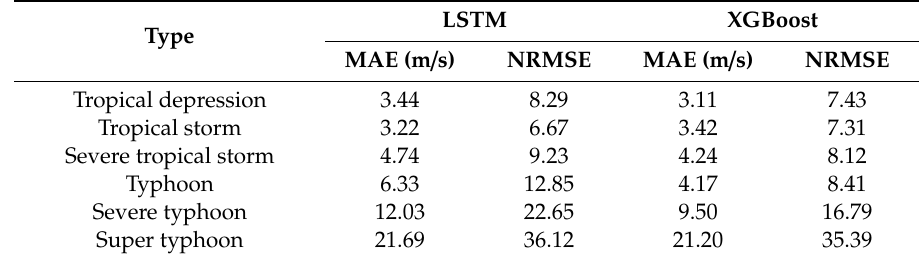
Table 11. LSTM and XGBoost model errors for di ff erent tropical cyclone intensity levels at an 18 h lead time. LSTM XGBoost Type MAE (m / s) NRMSE MAE (m / s) NRMSE Tropical